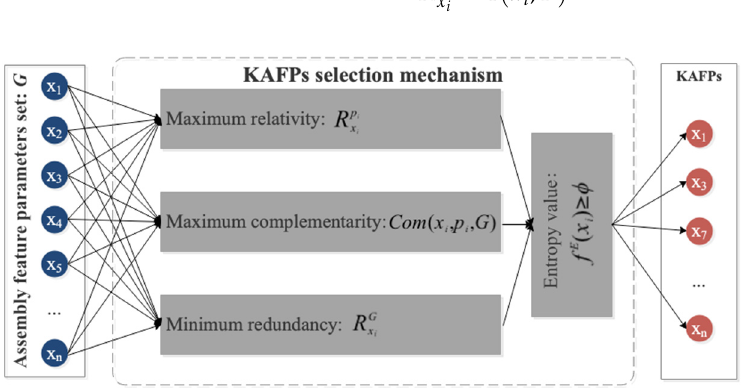
Figure 4. Selection mechanism of KAFPs.